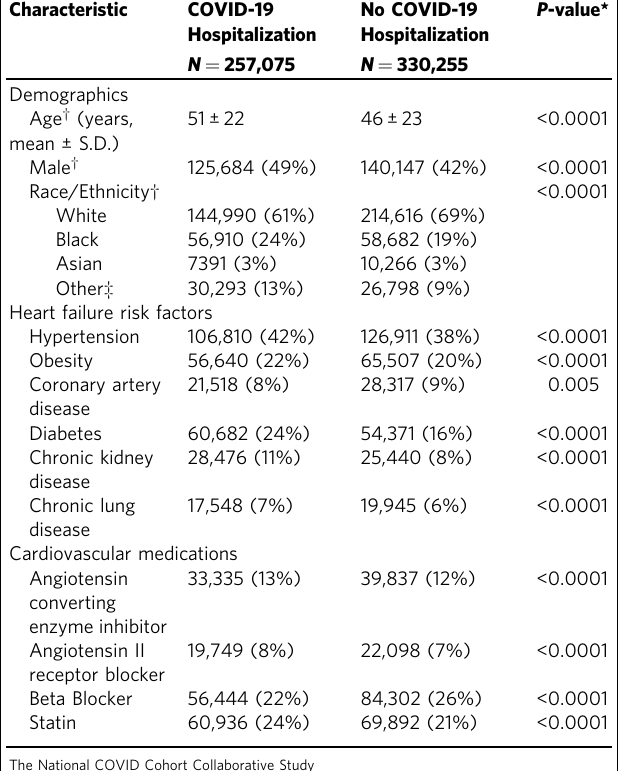
Table 1 Baseline demographic and clinical characteristics of patients hospitalized with and without COVID-19.